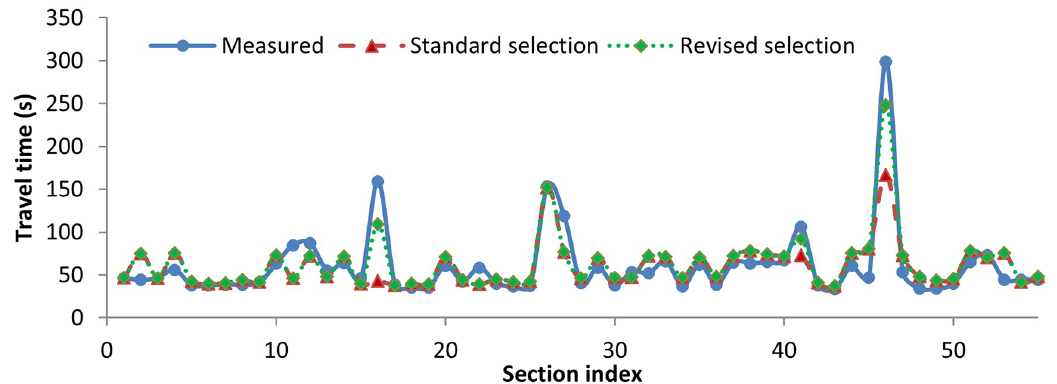
Fig 9. Measured and predicted travel times for a sample trip (standard selection vs. revised selection criterion).